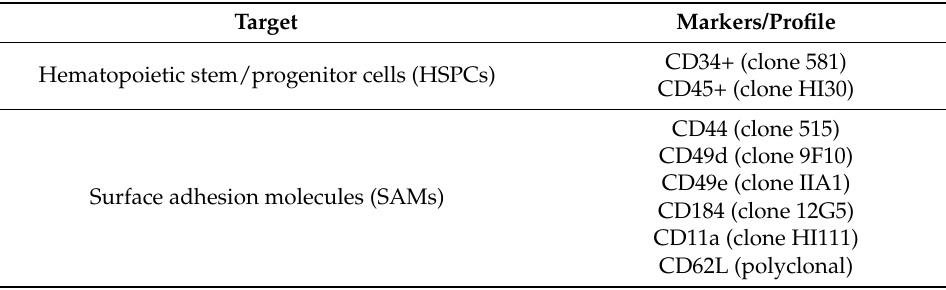
Table 1. The markers used in flow cytometry and immunohistochemistry